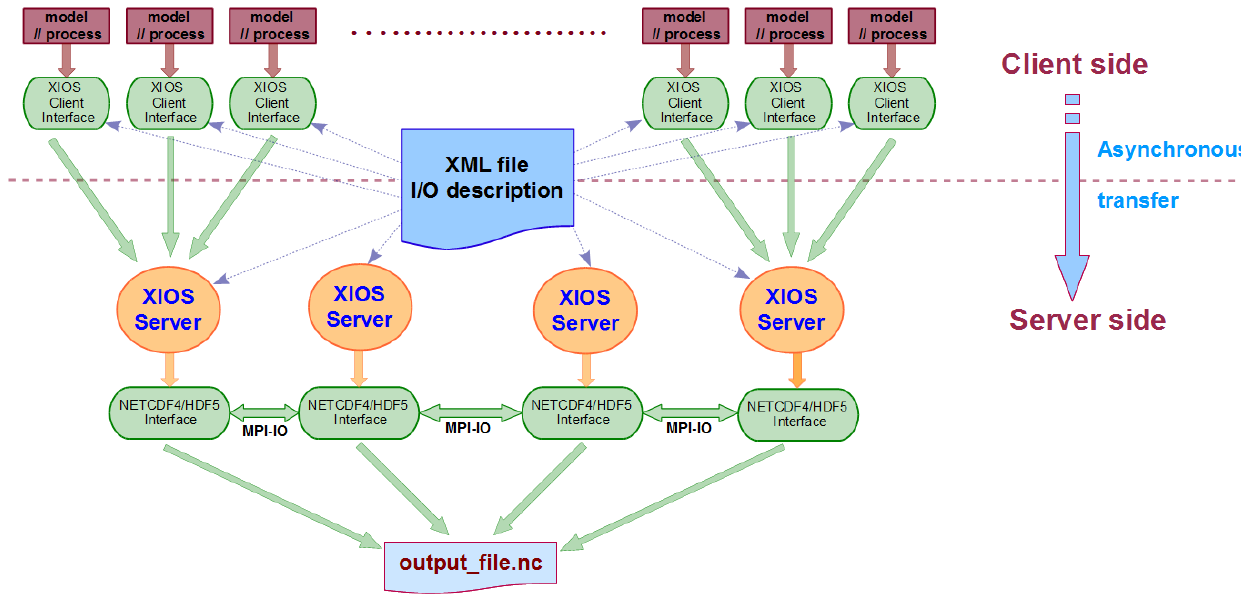
Figure A1. Overview of the XIOS architecture. Model processes are communicated with the XIOS servers using asynchronous MPI mes- sages. The framework is configured using an XML file (reproduced from Meurdesoif et al.,